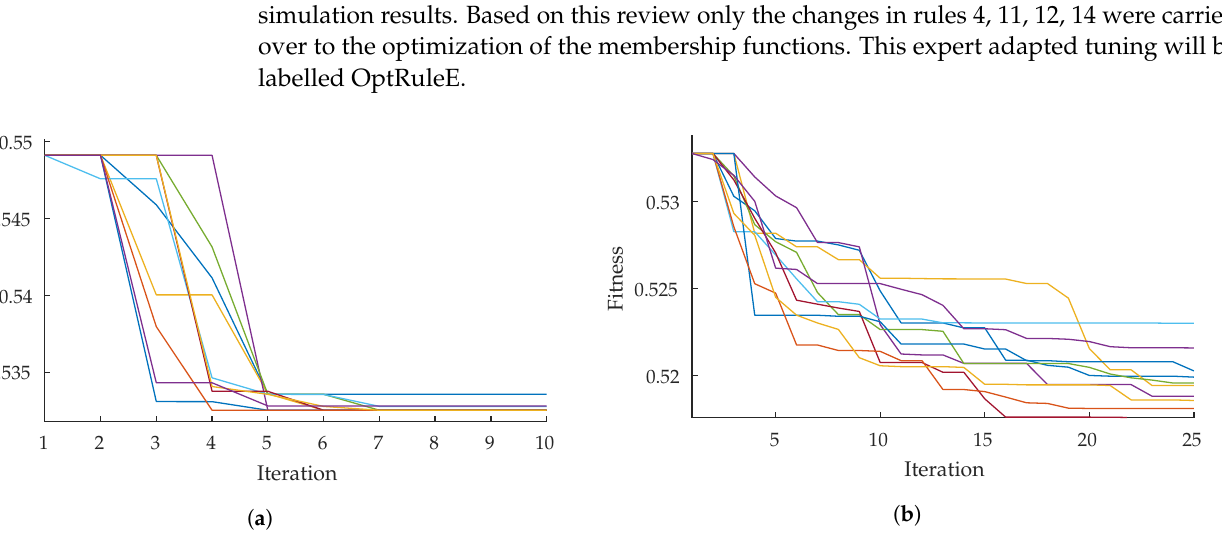
Figure 14. Convergence behavior of particle swarm optimization. ( a ) Rule base optimization. ( b ) Membership function optimization. Table 4. Optimized fuzzy logic controller rule